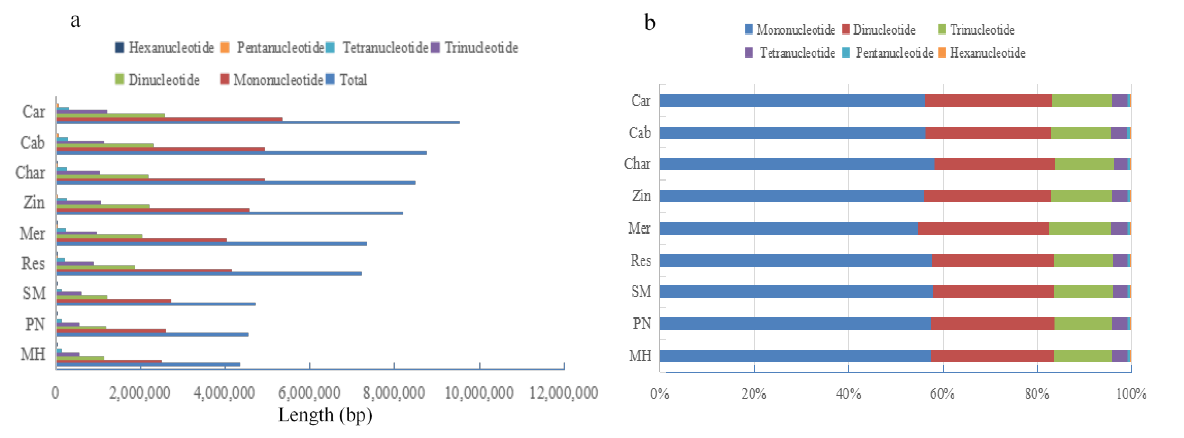
Figure 4. The overall lengths ( a ) and proportion ( b ) of microsatellites in genome sequences of different grape varieties.